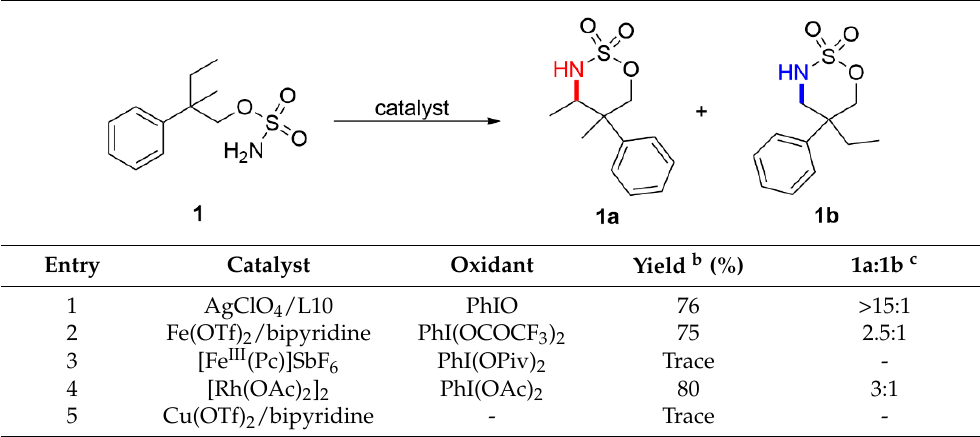
Table 3. The effects of metals on the reaction a .